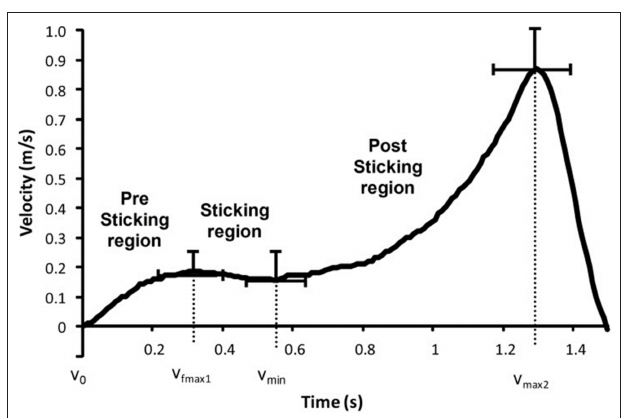
FIGURE 1 | Mean ± SD vertical barbell velocity during the last repetition in 6-RM back squats with a pre-sticking, sticking, and post-sticking region and following events: lowest barbell height (v 0 ), first peak barbell velocity (v max1 ), first located minimum barbell velocity (v min ), and second peak barbell velocity (v max2 ). Adapted from van den Tillaar et al.